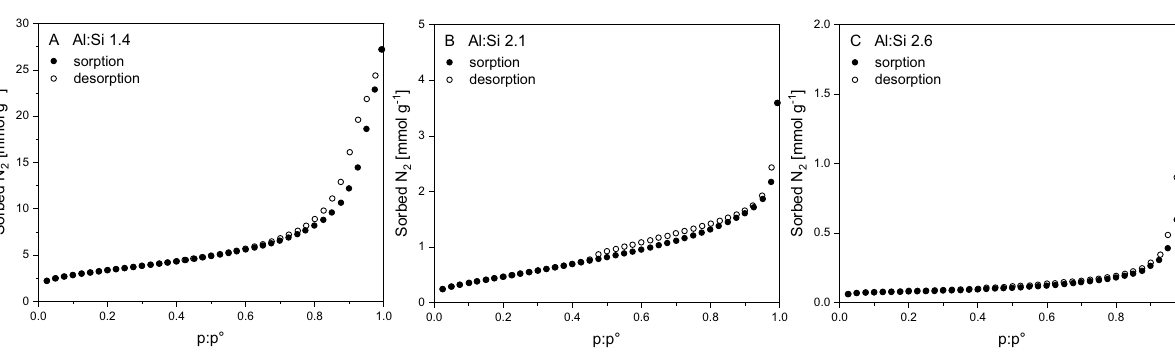
Figure 5. Transmission electron microscopy images of cryomilled Si-rich (Al:Si 1.4, left) and Al-rich (Al:Si 2.1 and 2.6, middle and right, respectively) short-range ordered aluminosilicates.